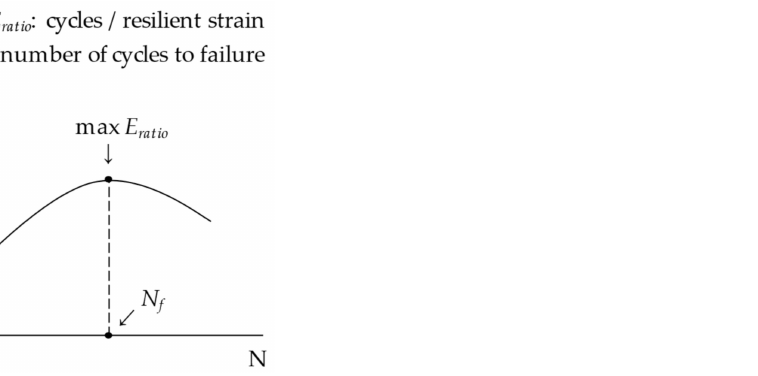
Figure 4. The calculation of the number of cycles to failure through the ITF energy